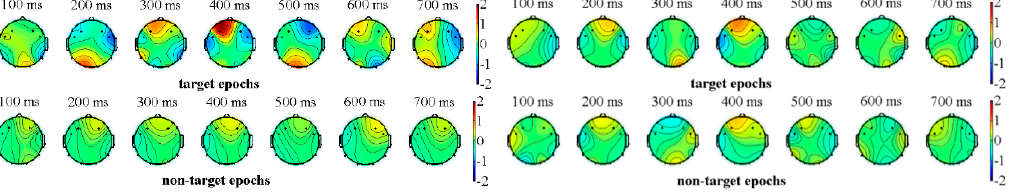
Figure 5. Brainwave activity mapping of target and non-target source stimulation from subject b and his corresponding impostor fb.